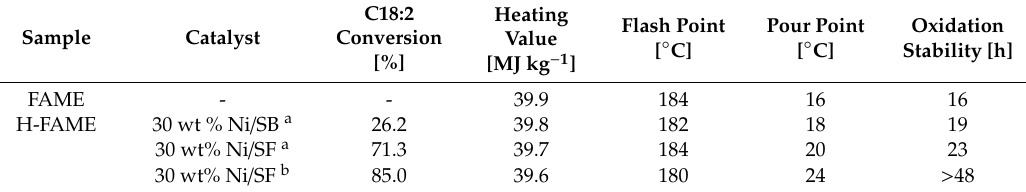
Table 4. Properties of FAME before and after partial